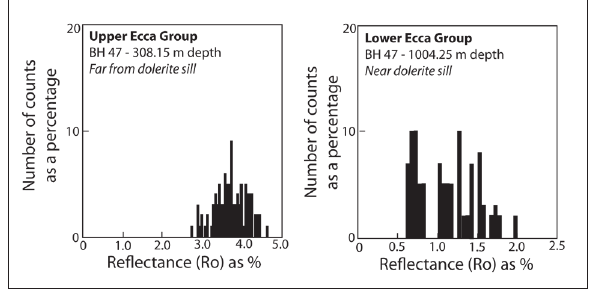
Figure 4: Examples of vitrinite reflectance data plotted as histograms for carbonaceous shale samples from borehole BH 47 distal from dolerite sills and in proximity to dolerite sills.